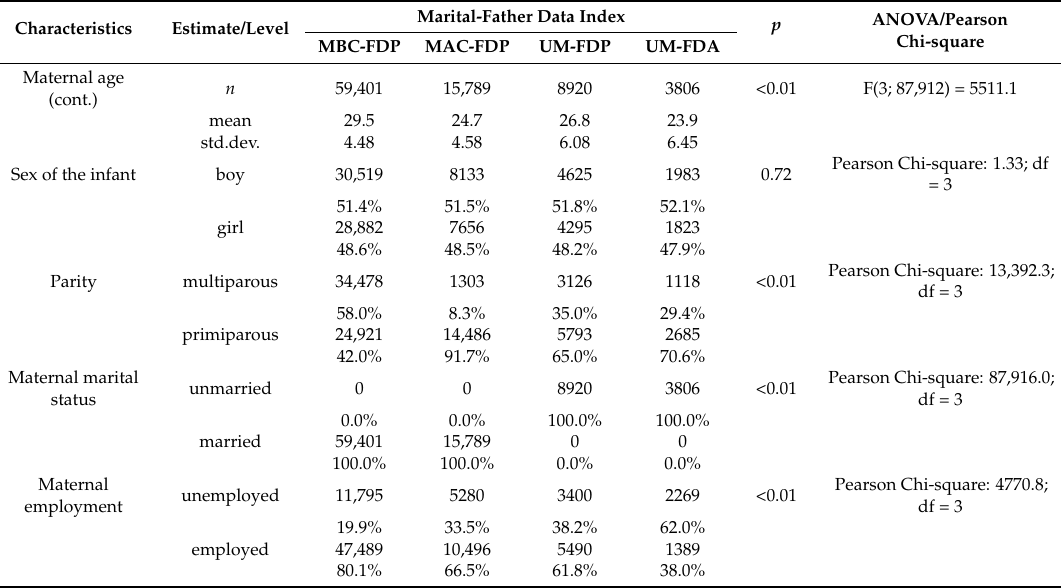
Table 3. Distribution of characteristics of singleton, live births stratified for Marital-Father Data index.